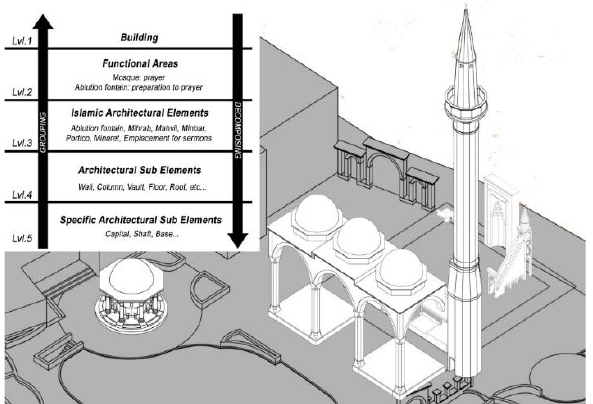
Figure 10. The semantic LoD classification and the example showing the LoD